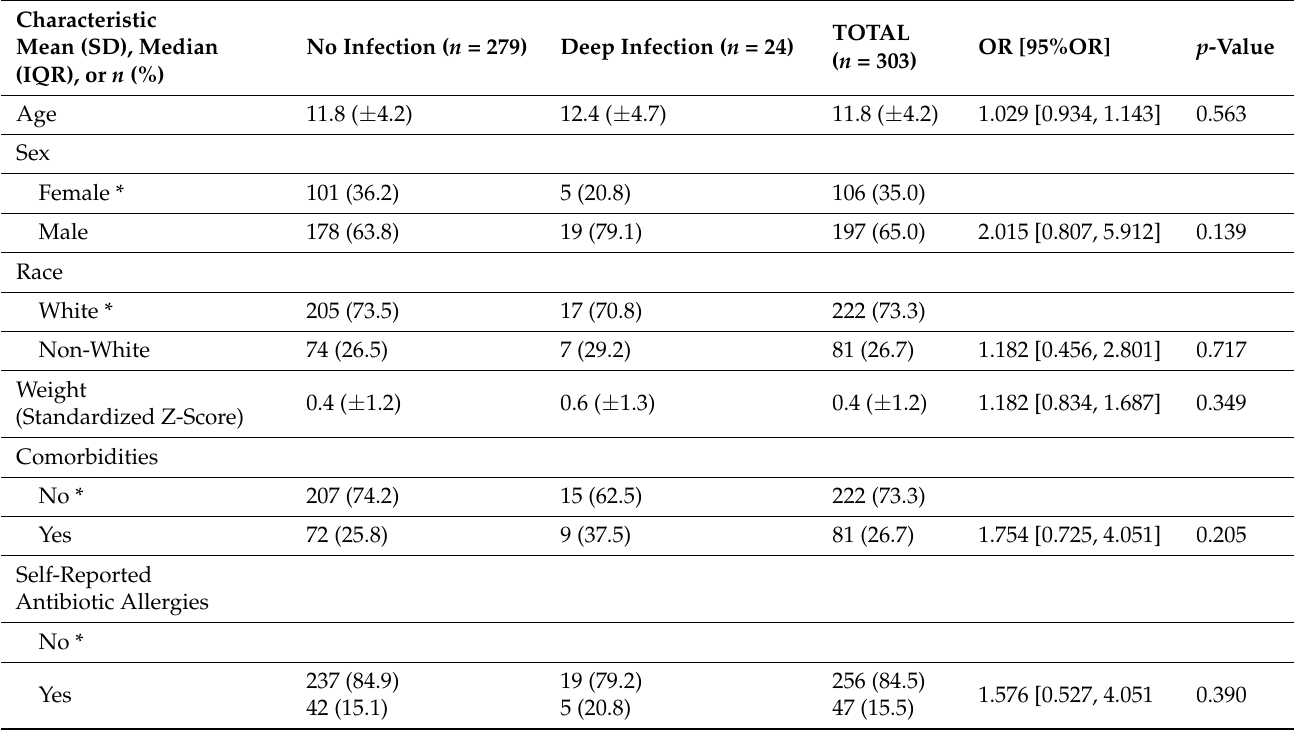
Table 2. Patient Demographic Characteristics.